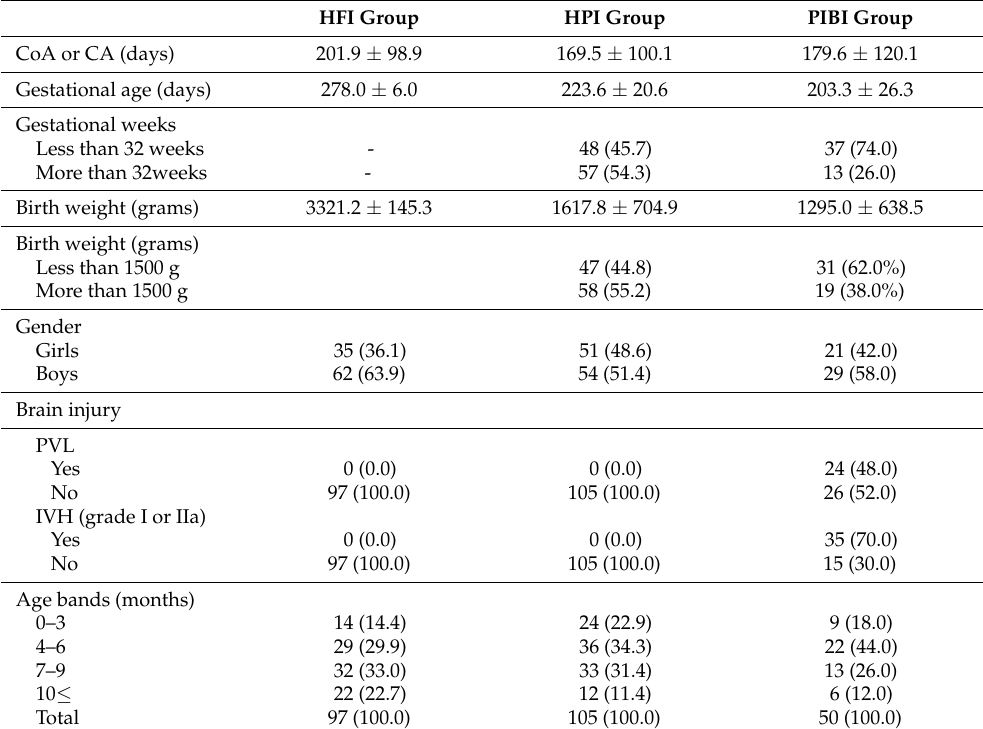
Table 1. The general characteristics of the